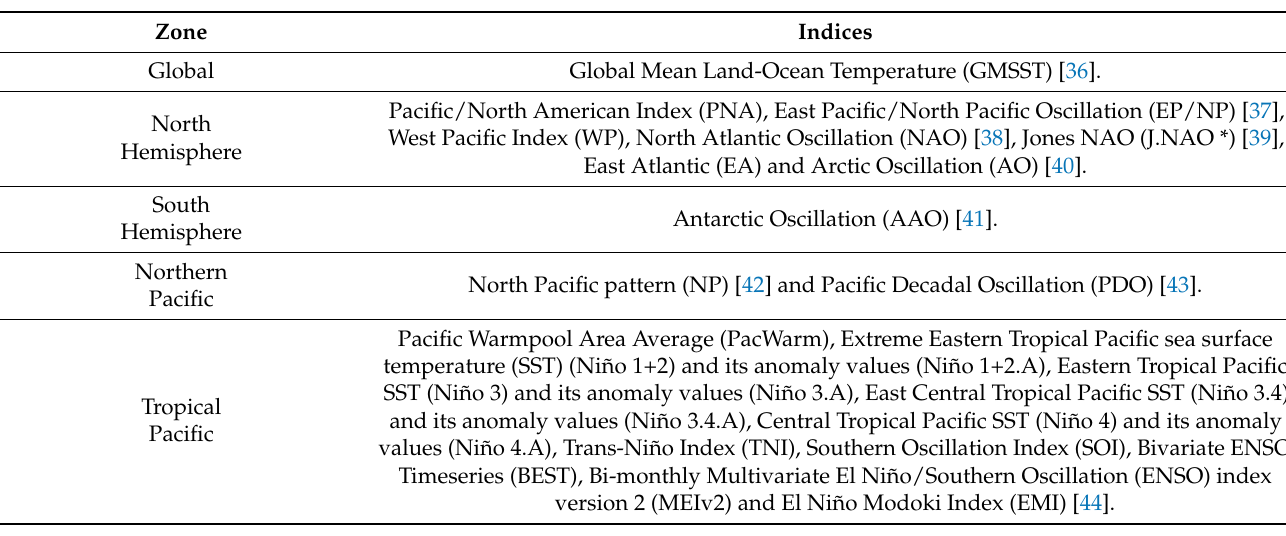
Table 1. Climate indices used in the study.